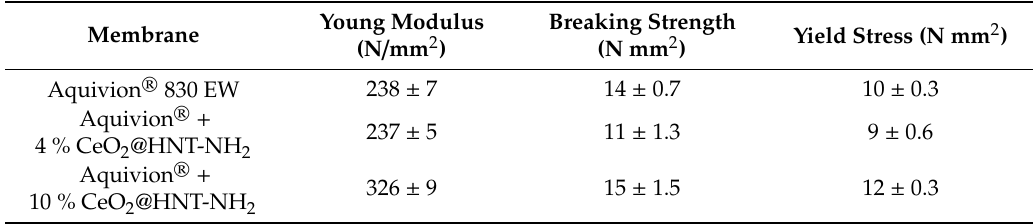
Table 2. Mechanical properties of reference membrane Aquivion ® 830EW and composite membrane